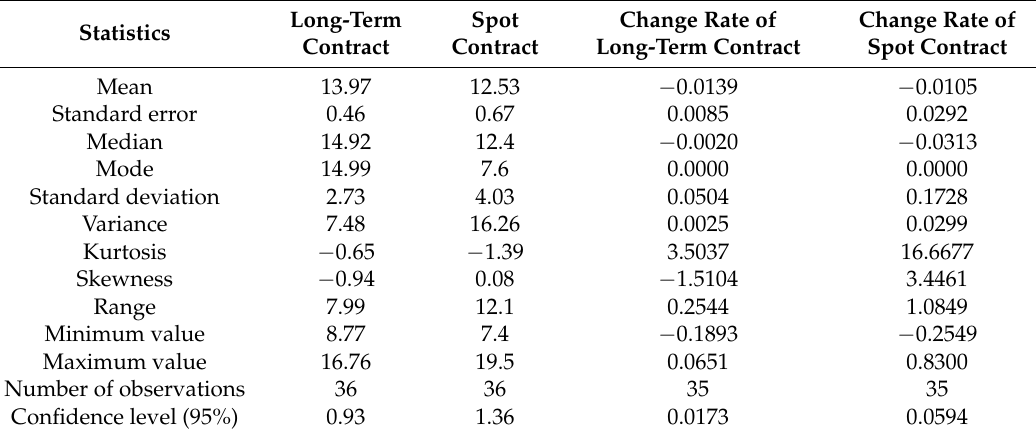
Figure 2. The price of spot and long-term contracts and the rate of price change. Table 5. Descriptive statistics on price